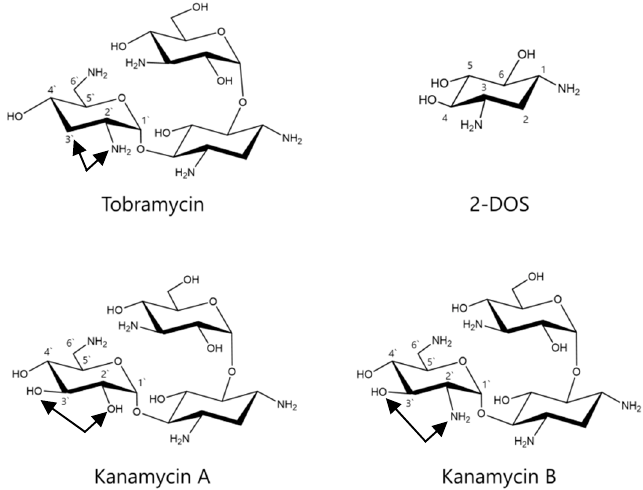
Figure 15. Structures of 2-DOS, tobramycin, kanamycin A, and kanamycin B.